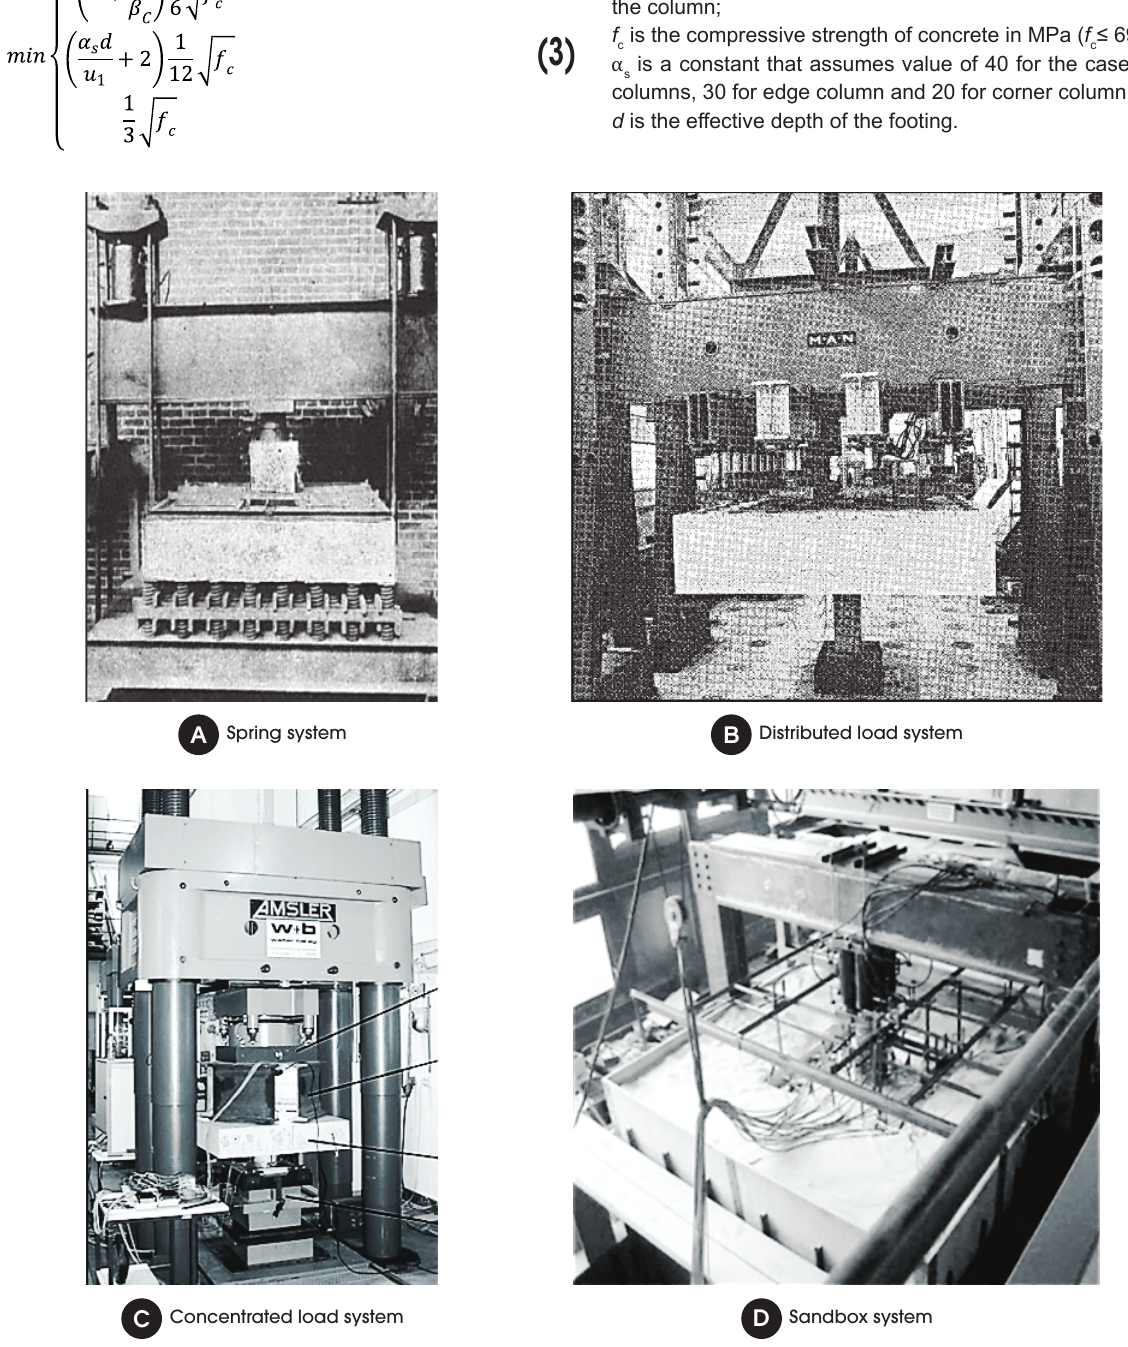
Different test systems used to evaluate punching shear resistance of